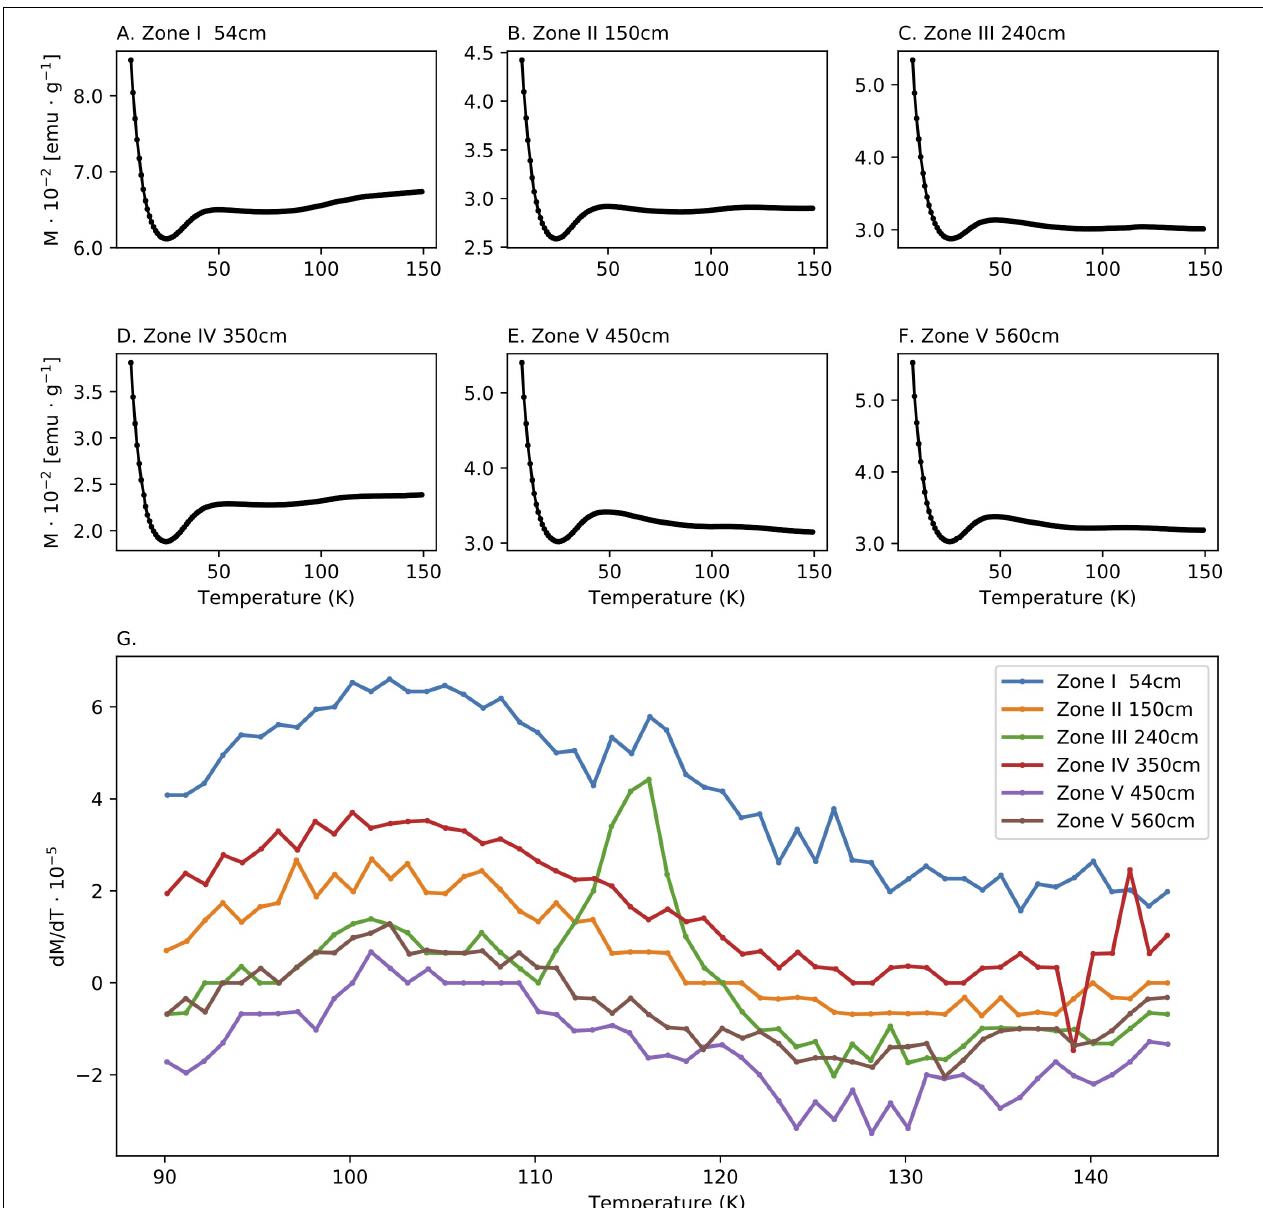
FIGURE 4 | Low temperature measurements. (A–F) Zero field cooling (ZFC) curves of samples collected from the five diagenetic zones defines in (G) First derivative of the curves shown in (A–F) around the Verwey transition temperature.